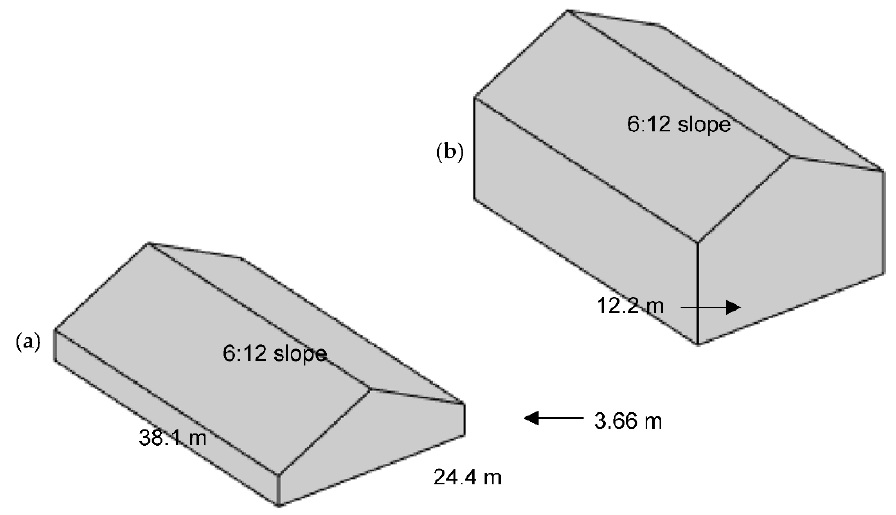
Figure 1. Buildings examined: ( a ) 3.66 m eave height; ( b ) 12.2 m eave height.